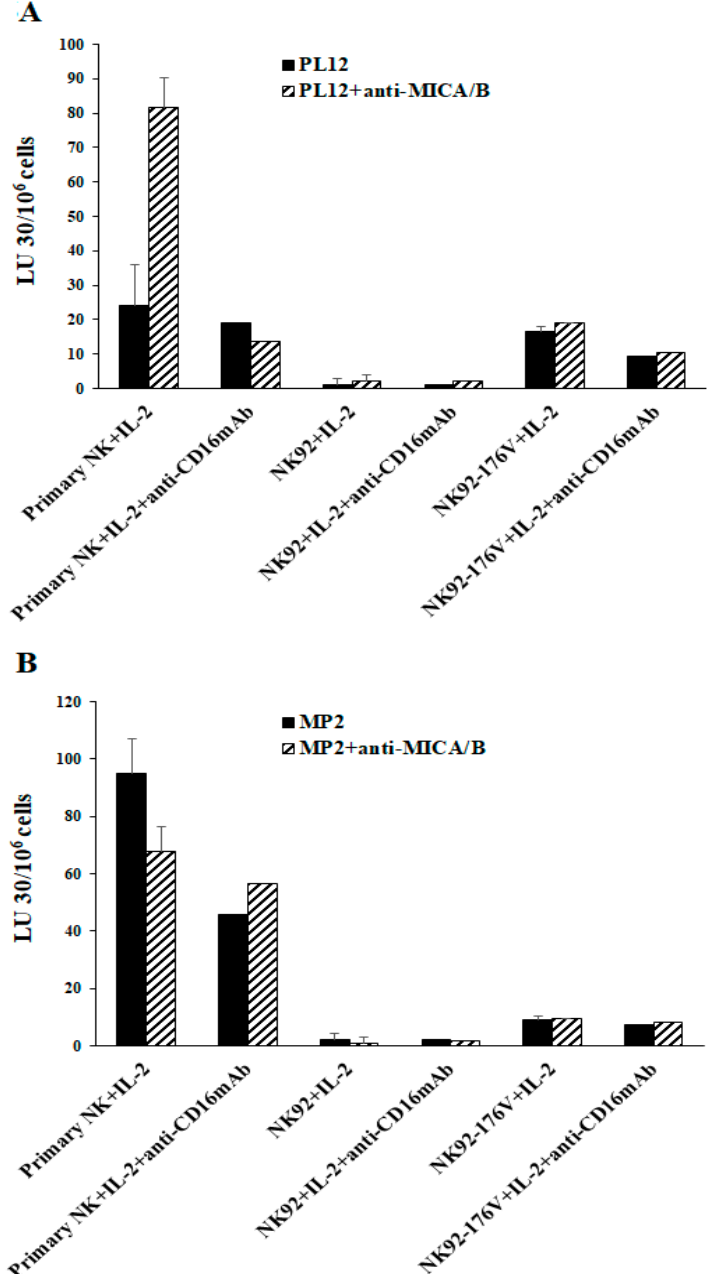
Figure 5. Higher levels of NK cell-mediated ADCC were seen in freshly isolated primary NK cells vs. in NK92 and NK92-176V. Freshly purified primary NK cells, NK92, and NK92-176V cells were either treated with IL-2 (1000 U/mL) or a combination of IL-2 and anti-CD16 mAbs (3 µg/mL) for 18 h and were used as effector cells to measure NK cell-mediated ADCC against PL12 ( A ) and MP2 tumors ( B ), as described in Materials and Methods.